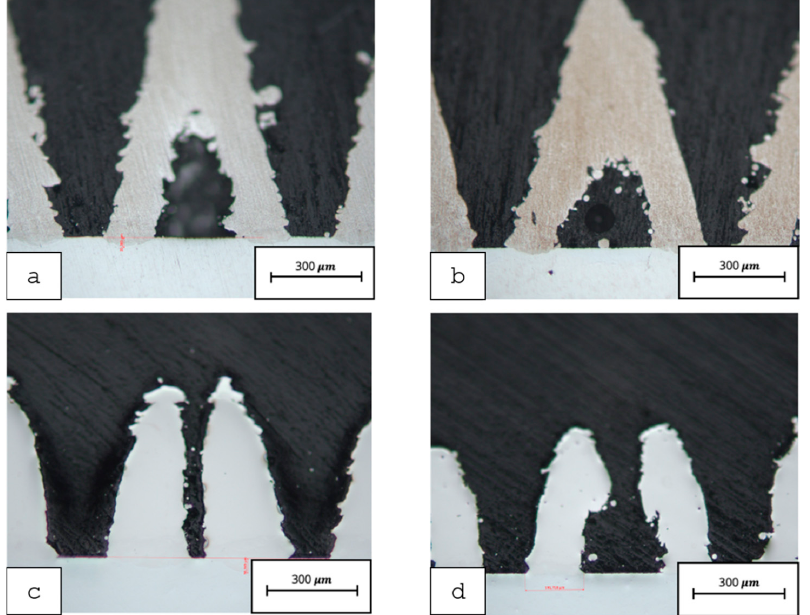
Figure 8. Light microscopy images of all four scanning strategies in the context of the initial parameter screening (solid NiTi SMA baseplate): ( a ) Contour-CLS; ( b ) Contour-CLI; ( c ) Cross-CLI; ( d ) Crosshair-CLI.